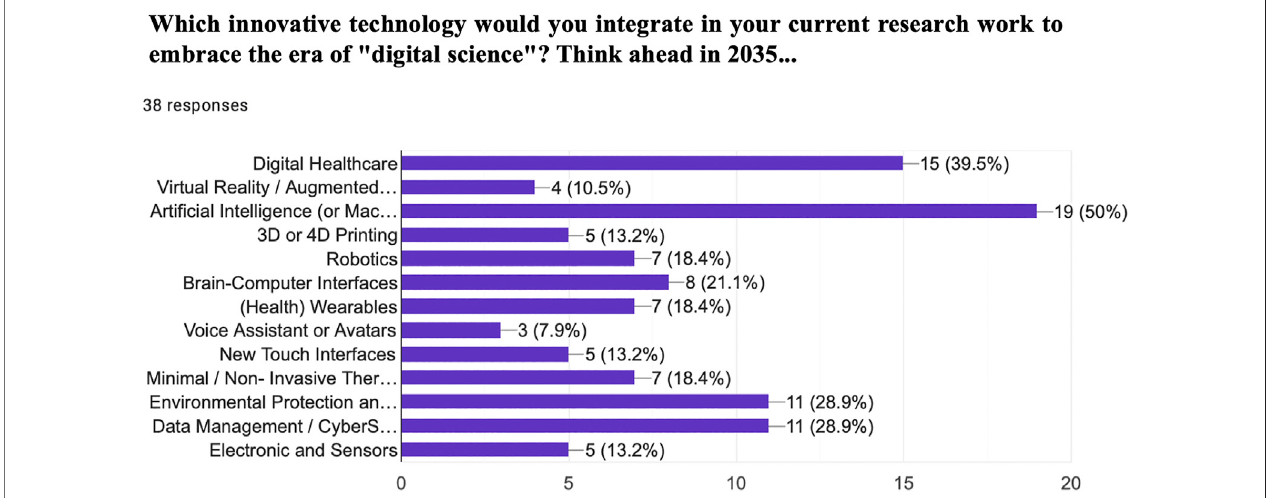
FIGURE 2 | Bar chart. Which innovative technology would you integrate in your current research work to embrace the era of “ digital science ” ? Think ahead in 2035... Options were: digital healthcare, virtual reality/augmented reality, arti fi cial intelligence (or machine learning, deep learning), 3D or 4D printing, robotics, brain- computer interfaces, (health) wearables, voice assistant or avatars, new touch interfaces, minimal non- invasive therapy systems, environmental protection and sustainability, data management/cybersecurity, electronic and sensors, other. The most relevant resulted “ Digital healthcare ” (39.5%), “ Arti fi cial Intelligence (or Machine learning, deep learning) ” (50%), and “ Data Management/Cybersecurity ” (28.9%) and “ Environmental Protection and Sustainability ” (28.9%).